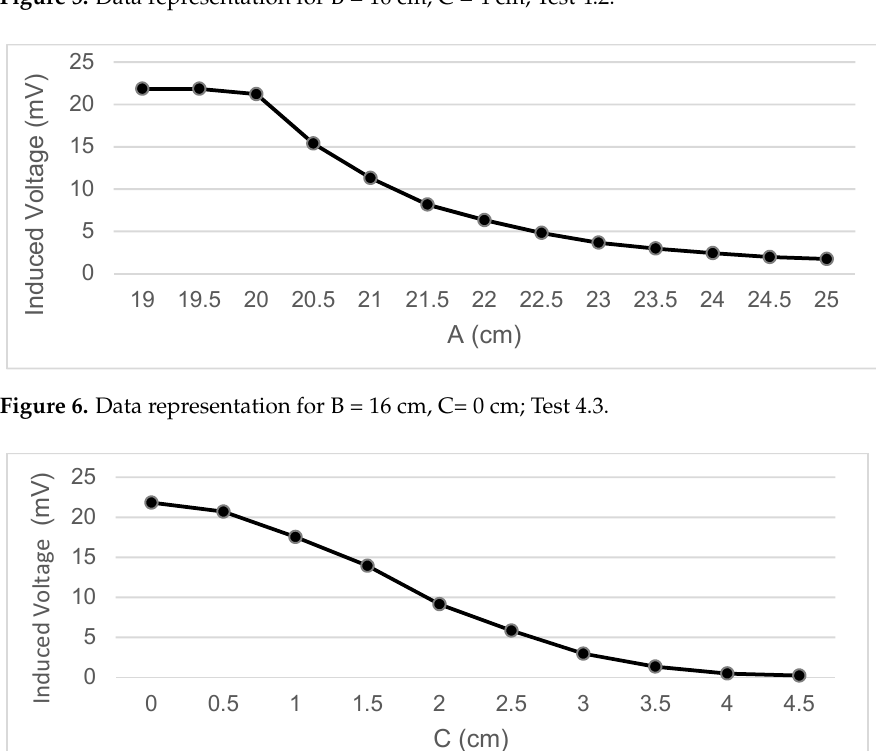
Figure 5. Data representation for B = 16 cm, C = 4 cm; Test 4.2.